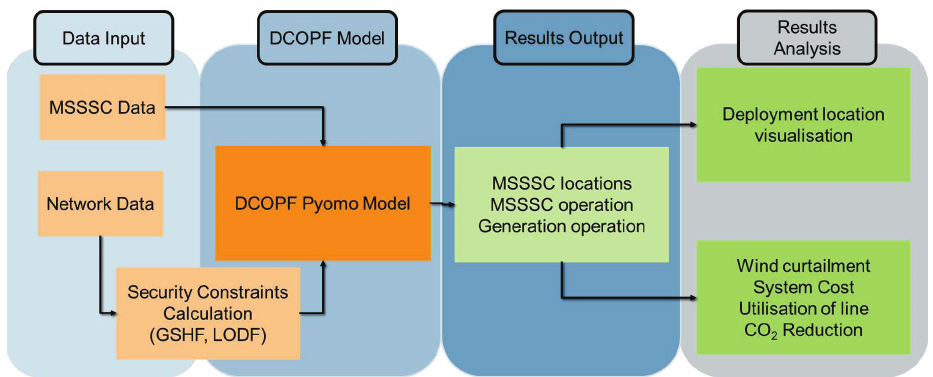
Figure 3. The architecture of the DCOPF